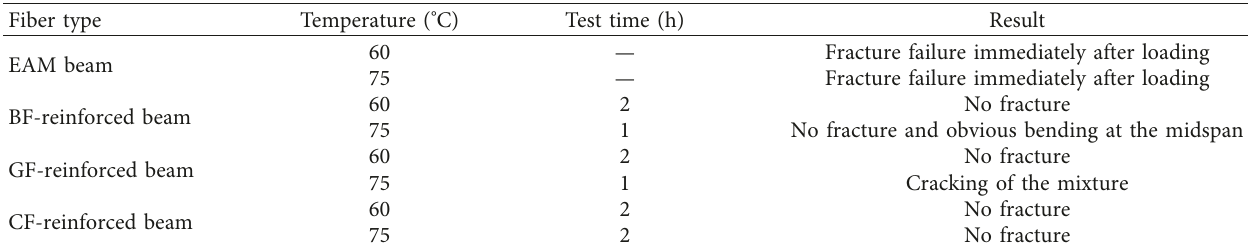
Figure 18: Room-temperature and low-temperature performances: (a) bending strength; (b) the maximum failure strain; (c) bending stiffness modulus in failure. Table 6: Fatigue test results of composite structures under wheel rolling at 60 and 75 °